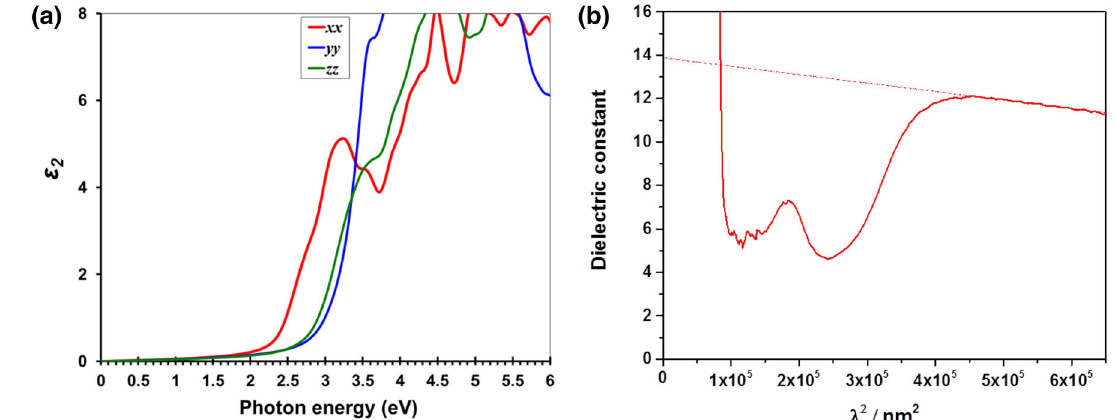
correspond to xx , yy , and zz components, respectively, adapted from [64] by permission of Elsevier and b plot of the dielectric constant vs. k 2 of Ta 3 N 5 thin film for electron effective mass determination